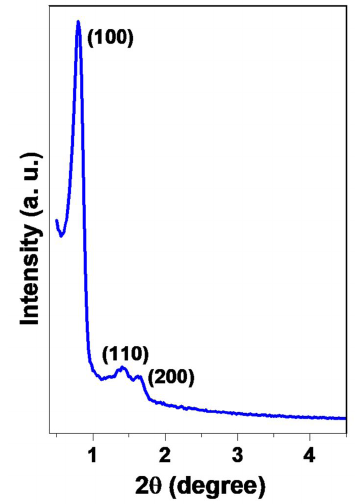
Figure 1. X‑ray diffraction patterns of SBA‑15 mesoporous ceramic